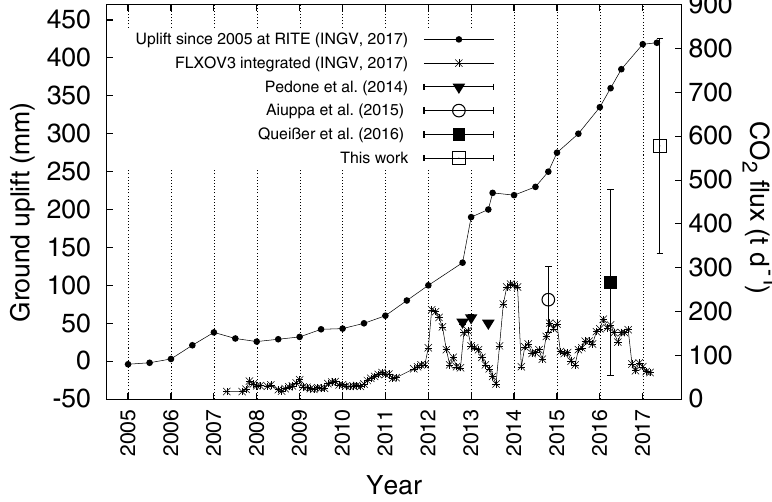
Figure 3. Ground elevation GPS data from the RITE GPS station near the center of CF and CO 2 fluxes measured at the Pisciarelli fumarole field. All flux values except FLXOV3 data are spatially integrated. FLXOV3 data are acquired by an automatic in situ station in units of gm − 2 d − 1 . To be comparable to the area-integrated flux values, the data were multiplied with the surface area of the Pisciarelli fumarole area. Two methods of calculating the area yielded very similar results. Approximating the vegetation-free area with a polygon yielded 4200m 2 , while approximating the surface with a rectangle with the dimensions 70m × 62m yielded 4340m 2 , which was used as it provides a lower-limit estimate of the